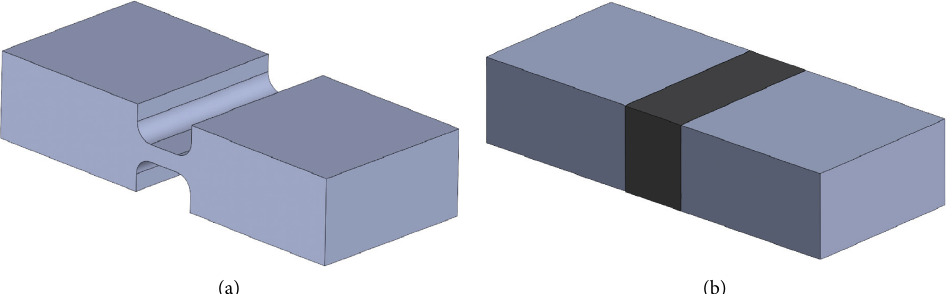
Figure 7: Two different compliant joints with relative motion.